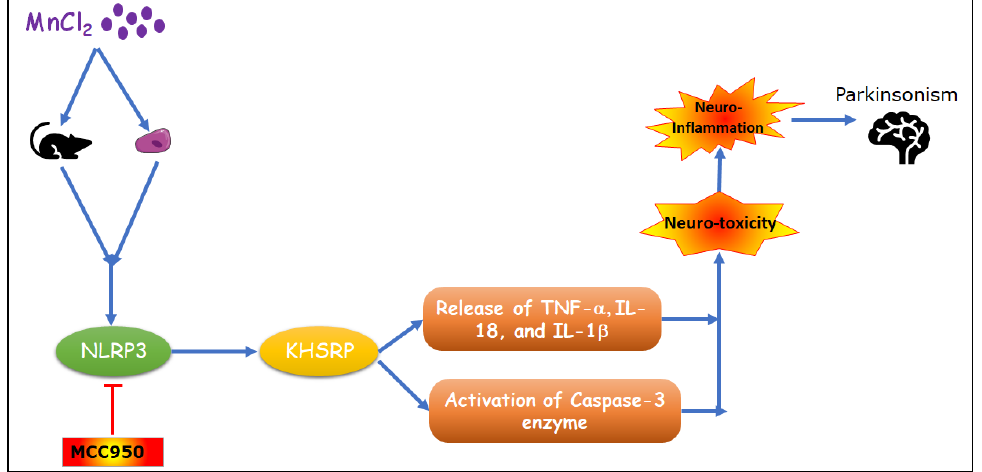
Figure 12. Schematic presentation of MnCl 2 -induced neurotoxicity.